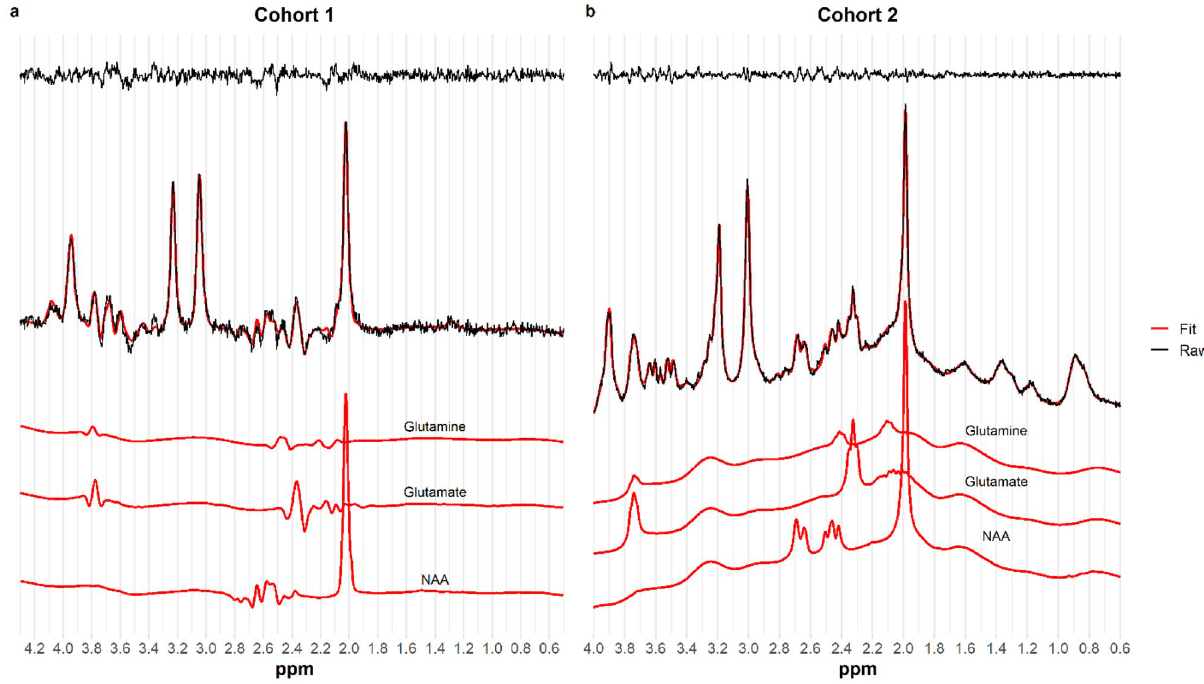
Figure 5. Example spectra. A: 3 T (PRESS), B: 7 T (STEAM). Residuals are shown at the top of both